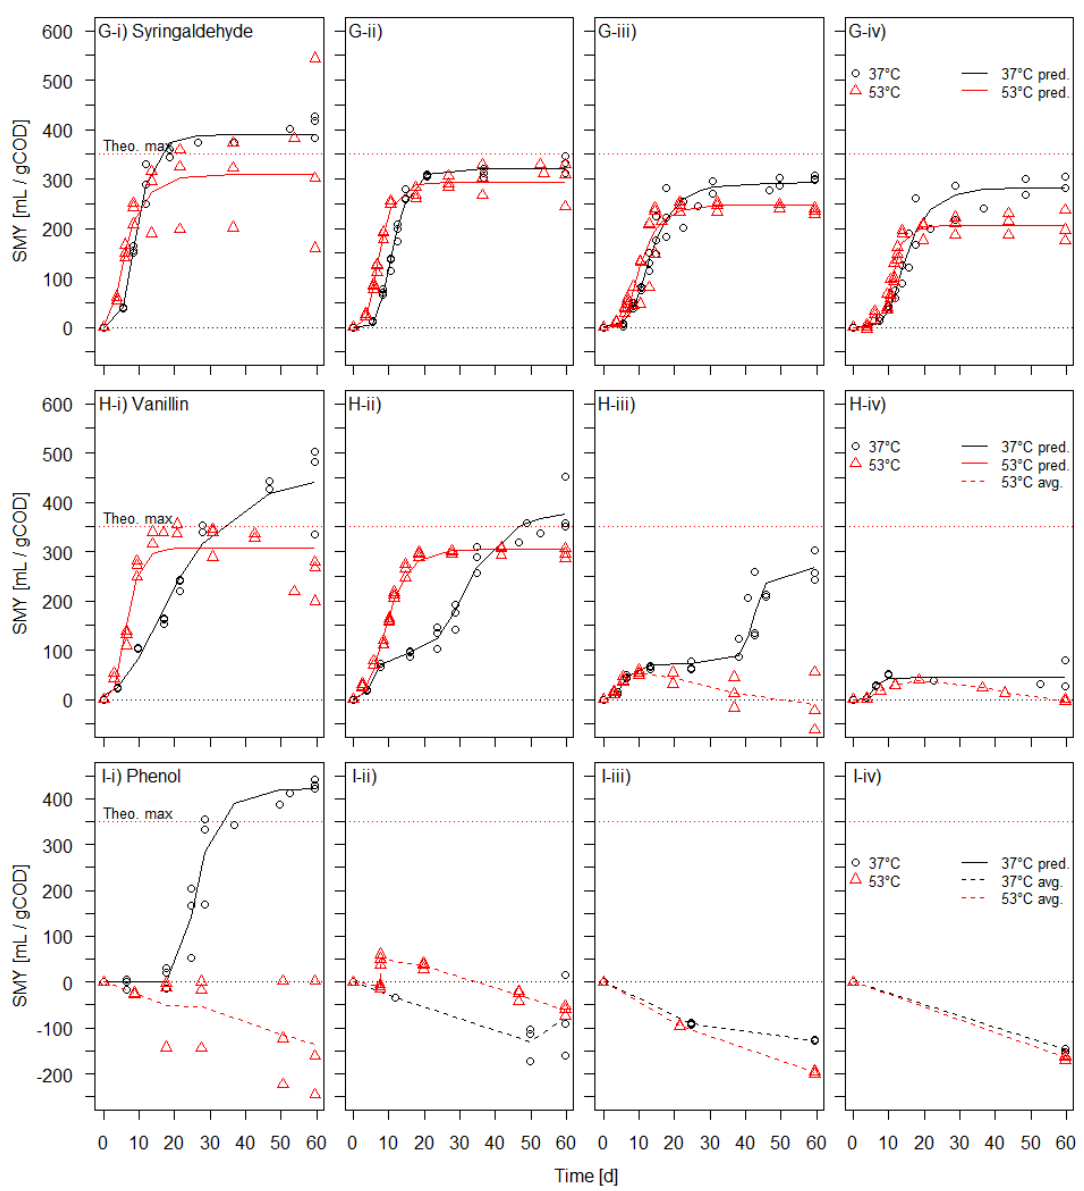
Figure 5. Measured specific methane yields for ( G ) syringaldehyde, ( H ) vanillin, and ( I ) phenol from their per batch-test added amounts of ( i ) 0.1 gCOD, ( ii ) 0.2 gCOD, ( iii ) 0.3 gCOD, and ( iv ) 0.4 gCOD under mesophilic and thermophilic conditions, along with the fitted modified Gompertz functions (n = 3 for all the test concentrations of the phenolic compounds at 37 °C and 53 °C, except n = 2 for 0.4 gCOD Syringaldehyde at 37 °C and 0.4 gCOD Vanillin at 37 °C and 53 °C. The Gompertz functions are not fitted to the data with negative mean measured methane yields).